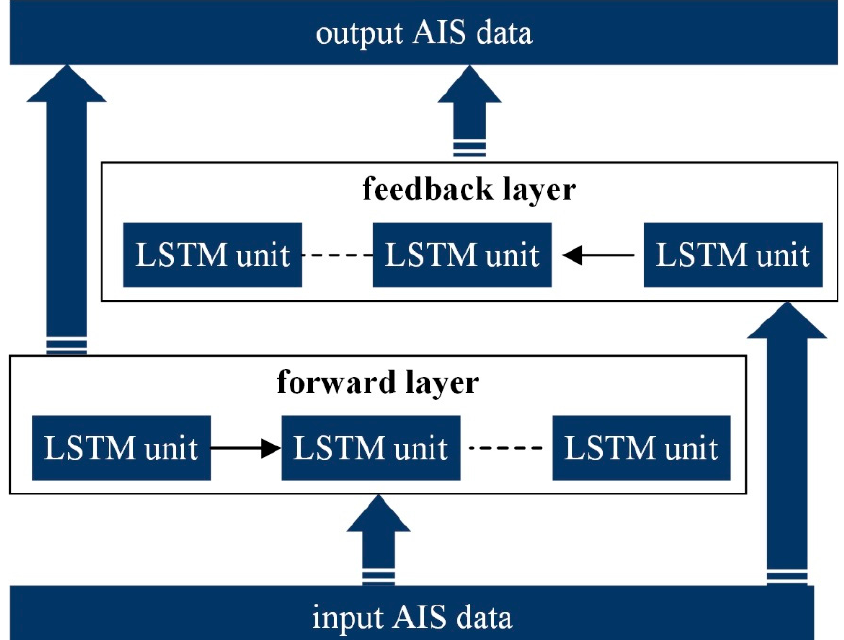
Figure 1. Overview for the Bi-LSTM model.